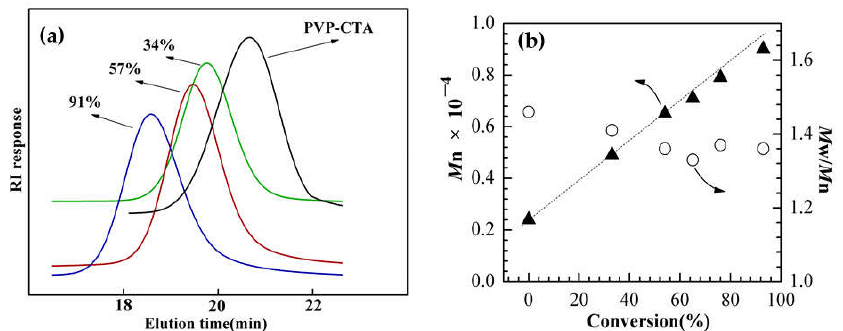
Figure 2. ( a ) shows the GPC elution curve of copolymer at different conversion rates; ( b ) shows the molecular weight and molecular weight distribution at different monomer conversion rates.